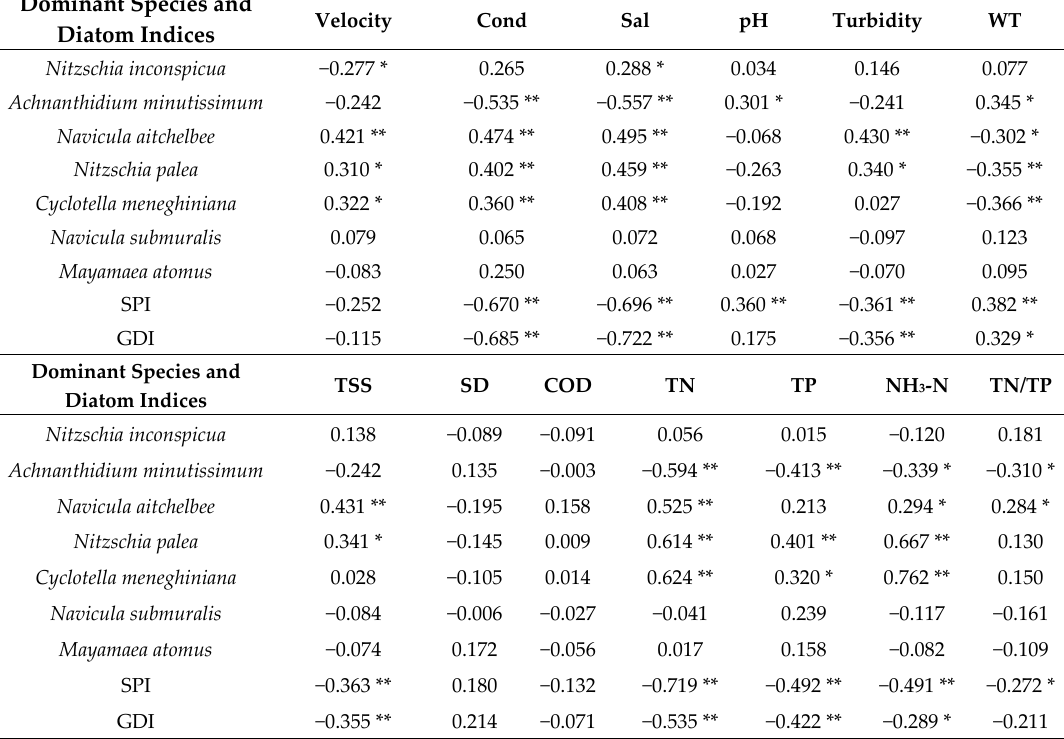
Table 5. Pearson’s correlation analysis of various environmental factors and diatom indices.